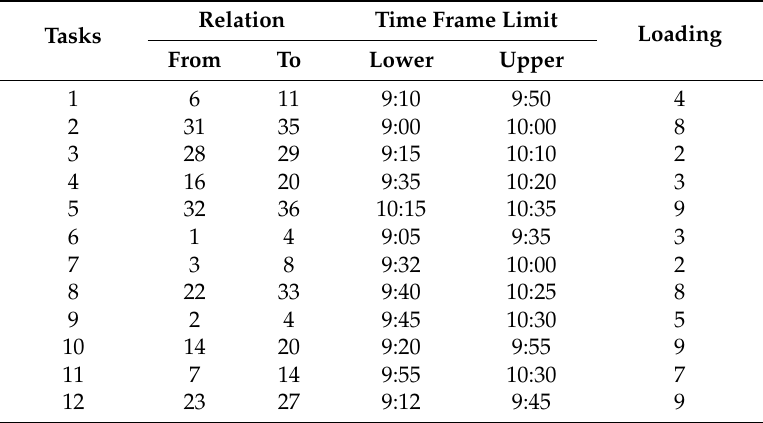
Table 5. Input parameters of the sensitivity analysis.